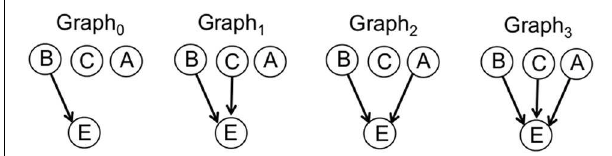
FIGURE 2 | Causal graphs. Explanation of the data observed by participants as causal graphs in which a causal influence over the effect (E), indicated by an arrow, exists for neither the target cause (C) nor the alternative (A) cause (Graph0), for the target cause but not the alternative cause (Graph1), for the alternative cause but not the target cause (Graph2), or for both candidate causes